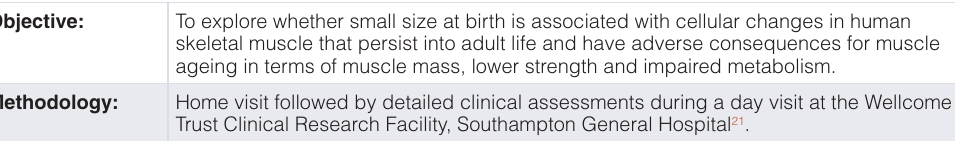
Table 7. Hertfordshire Sarcopenia Study (HSS) and extension